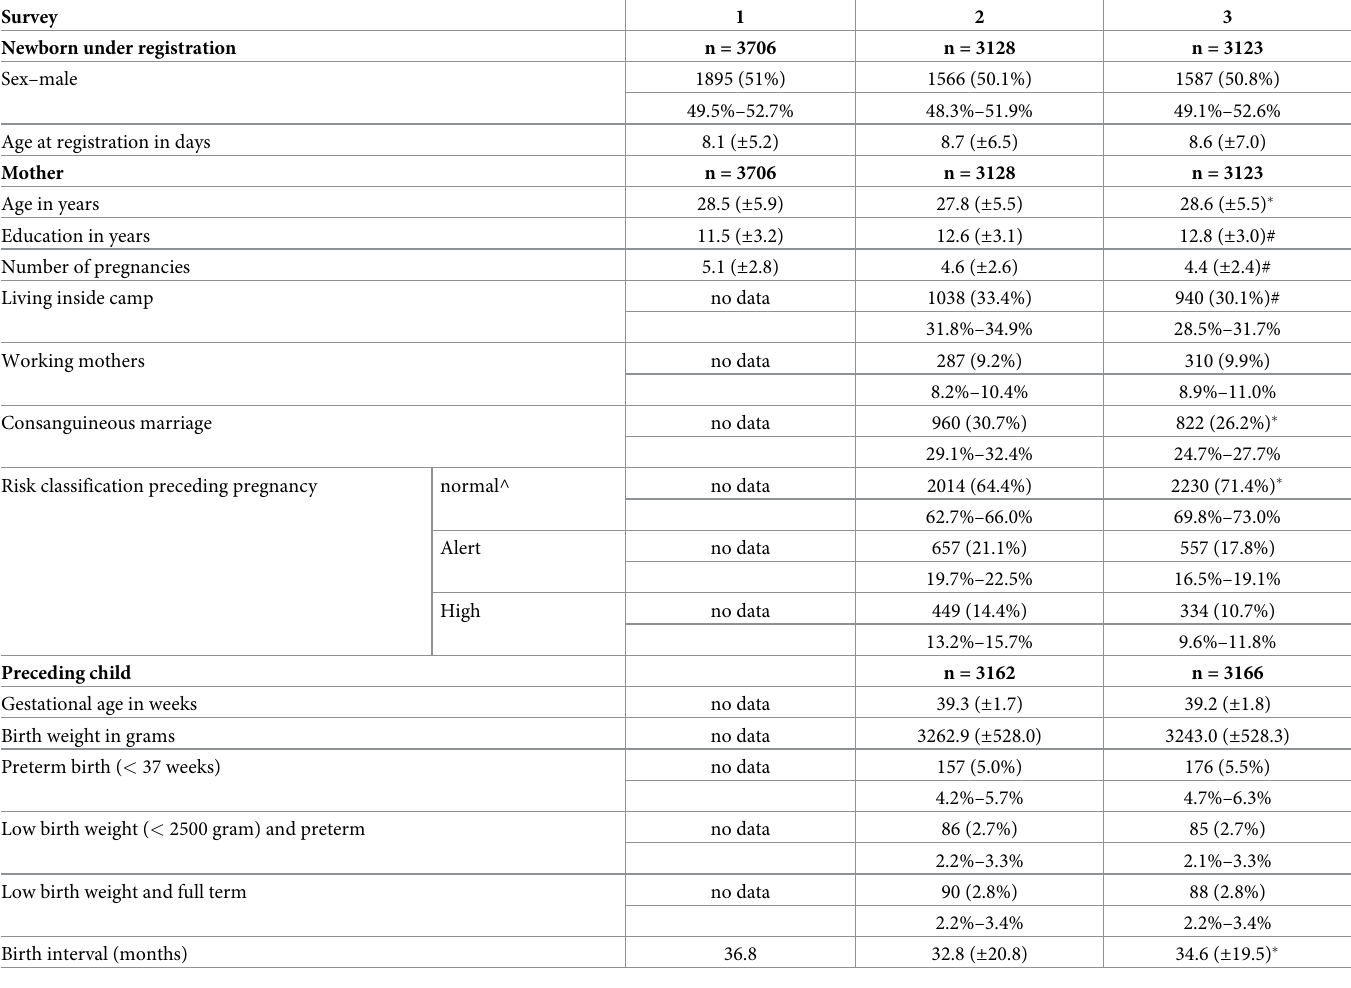
Table 1. Descriptive data of the study populations for each